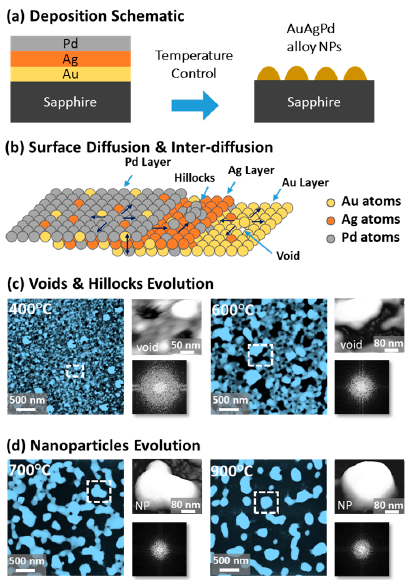
Figure 1. Evolution of ternary AuAgPd NPs on sapphire (0001), annealed between 400 and 900 °C for 450 s with 15 nm total thickness. ( a ) Tri-layer deposition schematic showing the deposition sequence of Au, Ag, and Pd layers (Au:Ag:Pd = 1:1:1). ( b ) Illustration of surface diffusion and inter-diffusion between metallic layers. ( c ) Atomic force microscope (AFM) top-views display the voids and nanoclusters evolution at relatively low temperature from 400 and 600 °C. ( d ) Irregular-connected to isolated-dome shaped AuAgPd alloy nanoparticle (NP) evolution between 700 and 900 °C. Corresponding insets present a zoomed-in view of the selected region and Fourier filter transform (FFT) power spectra.